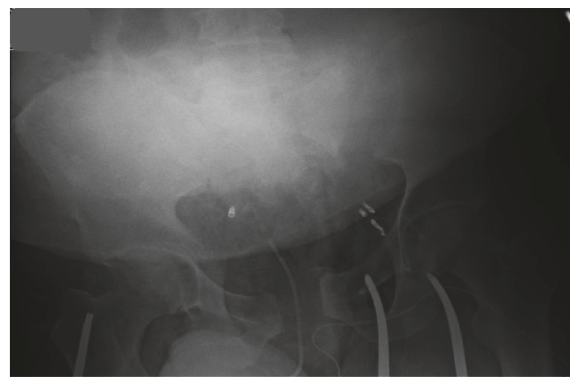
Figure 1: Portable radiograph of the pelvis. There is severe diastasis of the pubic symphysis, avulsion of the left superior pubic ramus, and separation of the left sacroiliac joint.